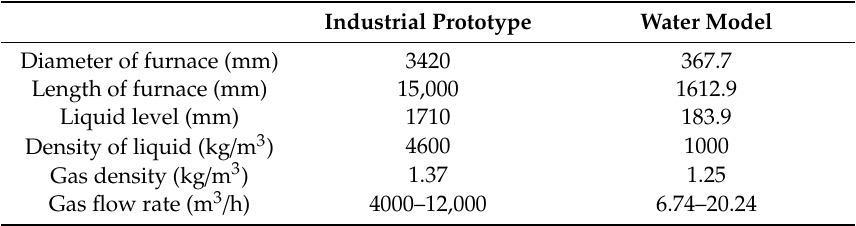
Table 1. Related model geometry parameters and material properties.